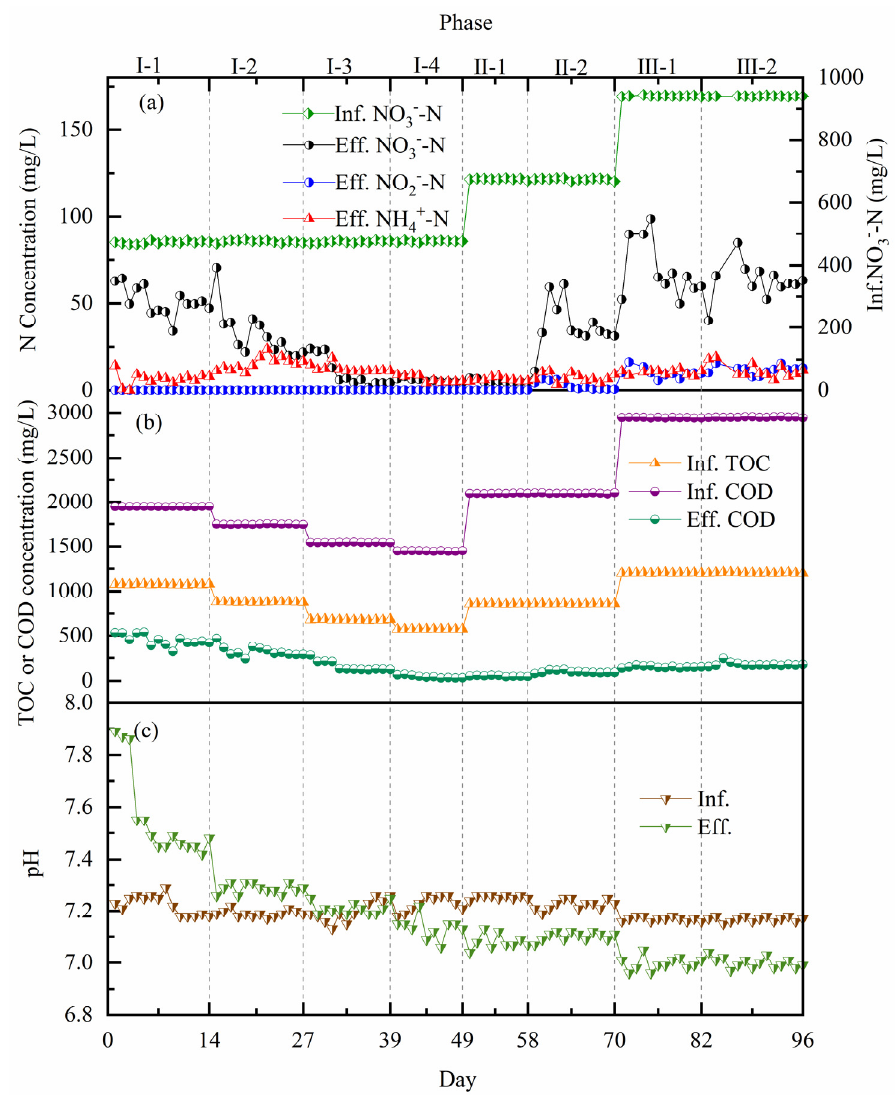
Figure 1. Changes in ( a ) nitrogen species, ( b ) COD or TOC, and ( c ) pH concentrations in denitrifying reactor A during the entire operation.